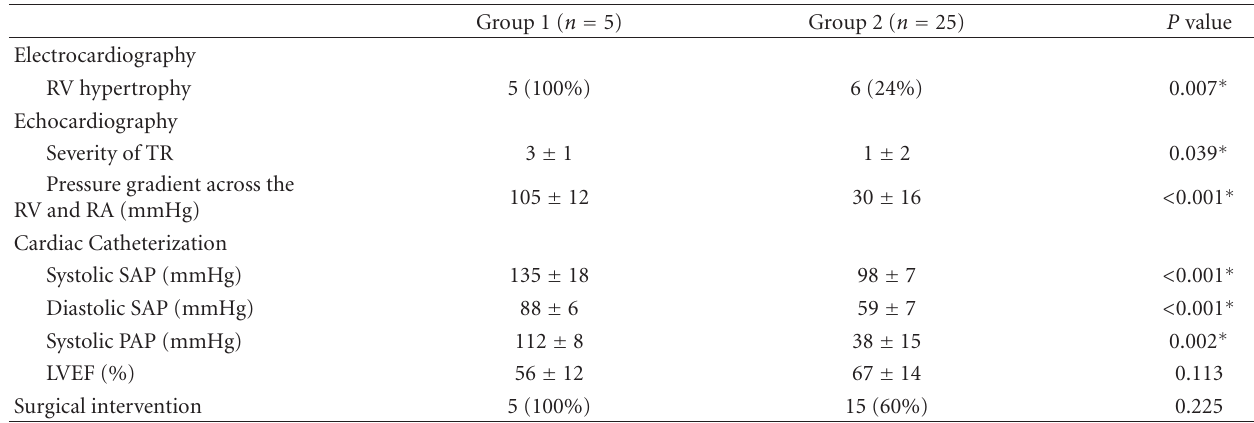
Table 2: A comparison of the electrocardiographic, echocardiographic, and hemodynamic characteristics between the two children